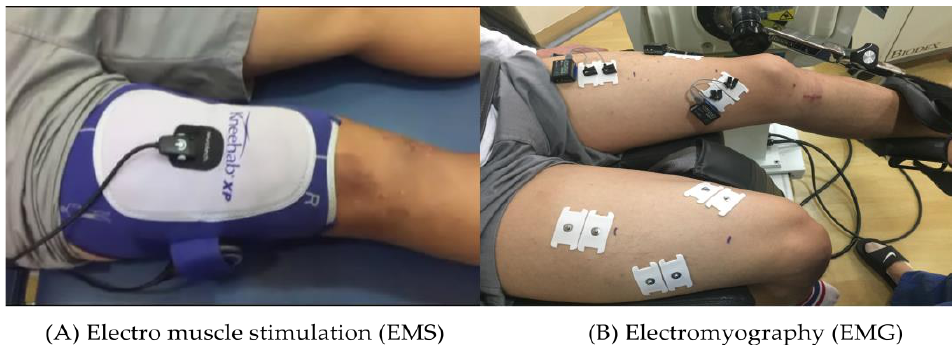
Figure 3. Measurement method of Electro Muscle Stimulation ( A ) and Muscle Activity ( B